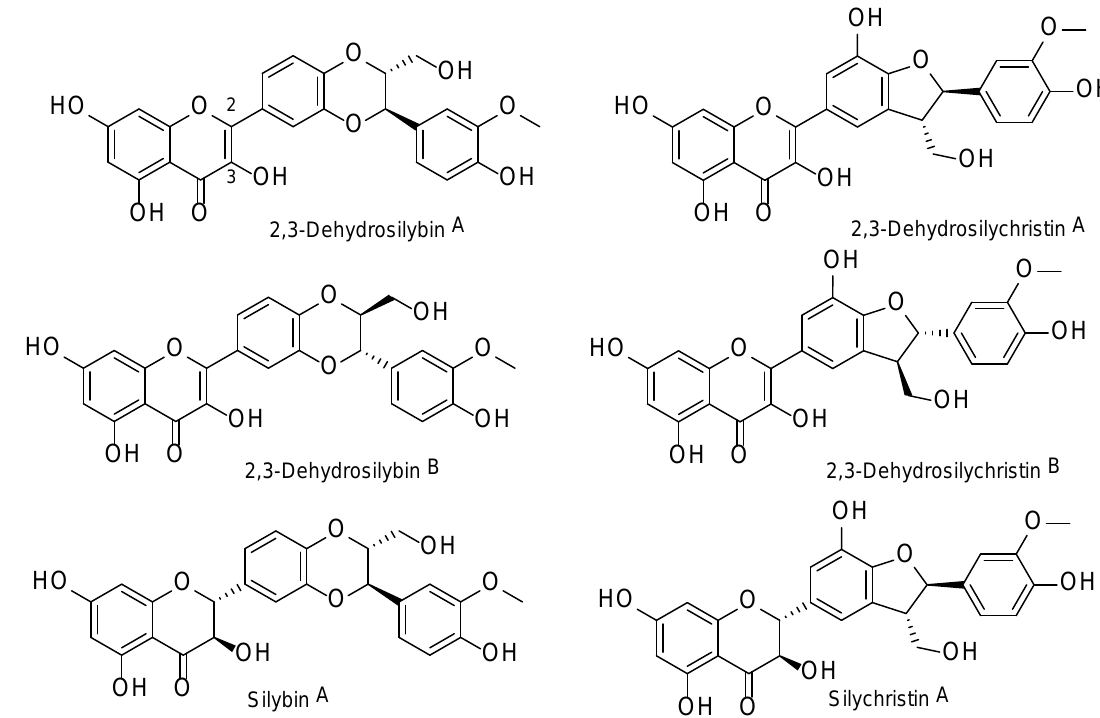
Figure 1. Chemical structure of 2,3-dehydrosilybin and 2,3-dehydrosilychristin enantiomers A and B, together with their respective parent flavonolignans silybin and silychristin (only A diastereomers are shown).